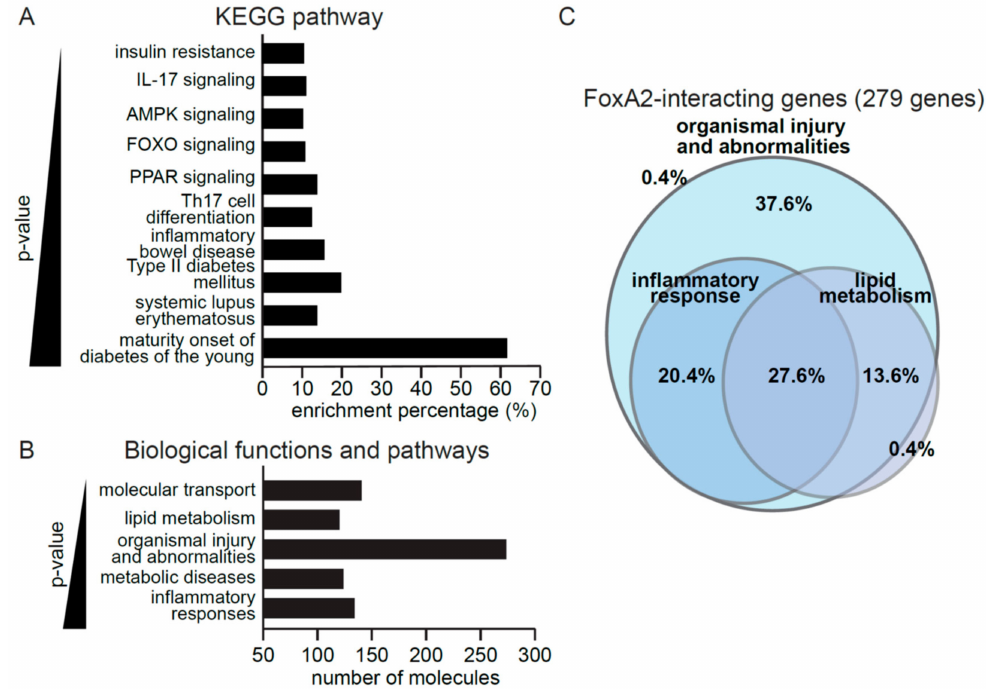
Figure 2. FoxA2 regulates genes associated with inflammation response to injury. ( A , B ) KEGG pathways ( A ) and top gene ontologies for biological functions ( B ) of FoxA2-regulated genes. A lower p -value indicates a stronger association with the indicated gene ontologies; ( C ) FoxA2 regulated genes play roles in various biological functions. A total of 279 genes are involved in metabolism, inflammatory response, and organismal injury. The percentage of genes implicated in the indicated biological functions is